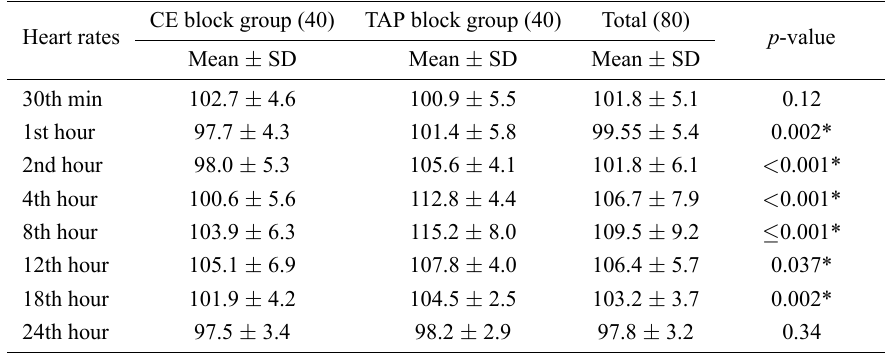
Table 3. Evaluation of heart rate between